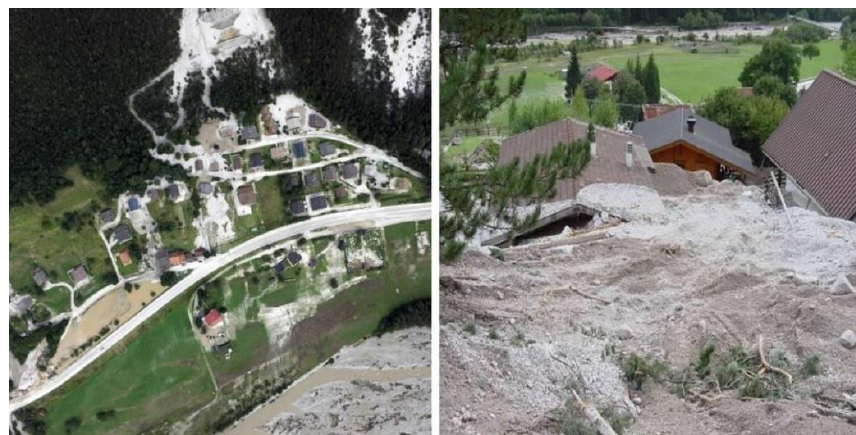
Figure 8. Debris flow events occurred in Malborghetto-Cucco in August 2003 (© Civil Protection of FVG region,